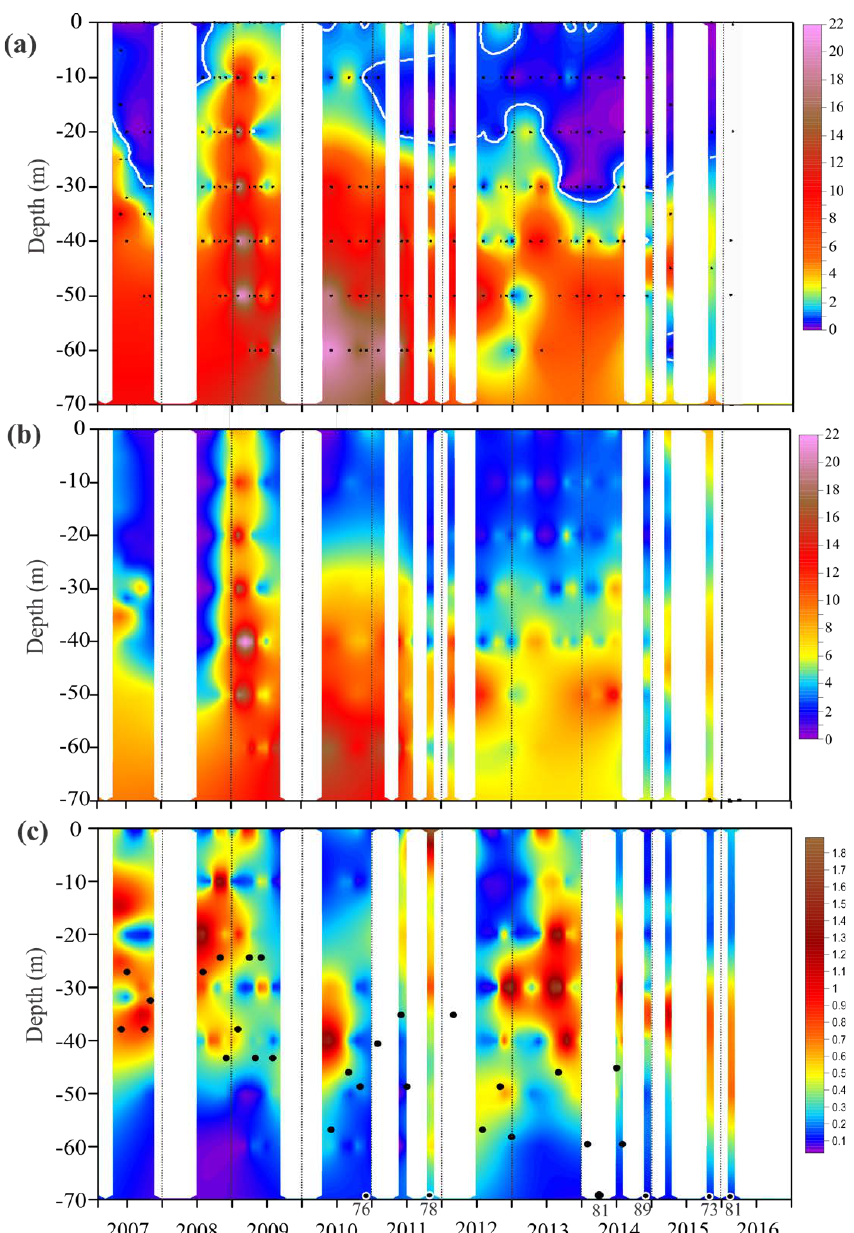
Figure 3. Time series of ( a ) nitrate concentration (μM); the white line indicates the 1 μM isoline, which represents the nitracline depth, and black dots indicates sampling depths; ( b ) silicate concentration (μM); ( c ) chlorophyll a concentration (mg m −3 ); black circles indicate the depth of the euphotic zone (m) and values off scale are shown below. White areas indicate periods when no data were obtained.